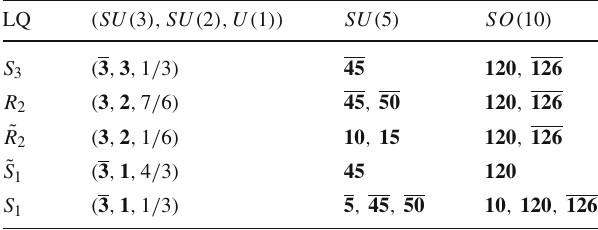
Table 1 Transformation properties of scalar LQs under the SM gauge group. The list of the most relevant SU ( 5 ) ( SO ( 10 ) ) representations that accommodate them is presented in the third (fourth) column. We assume the standard embedding of U ( 1 ) charges in SO ( 10 )